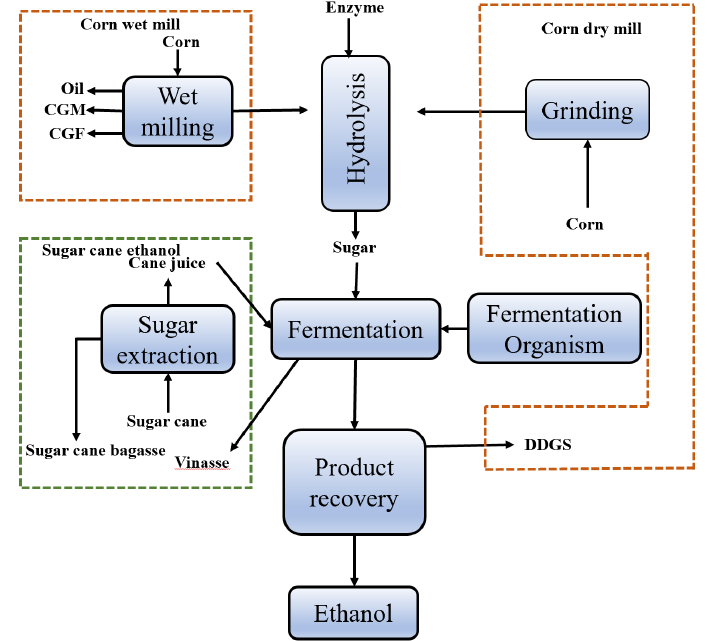
Figure 2. Global bioethanol production (source: www.afdc.energy.gov/data/).